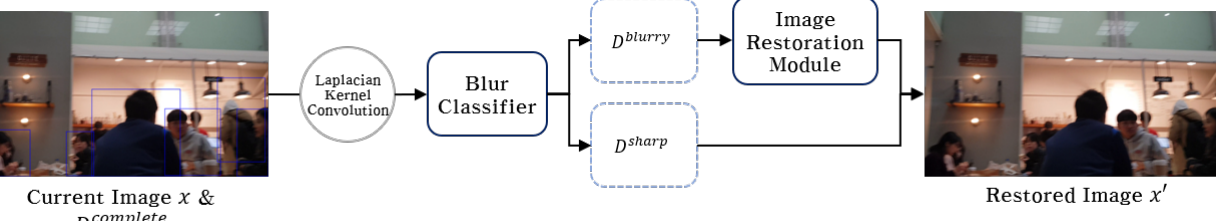
Figure 3. Schematic representation of the proposed site restoration